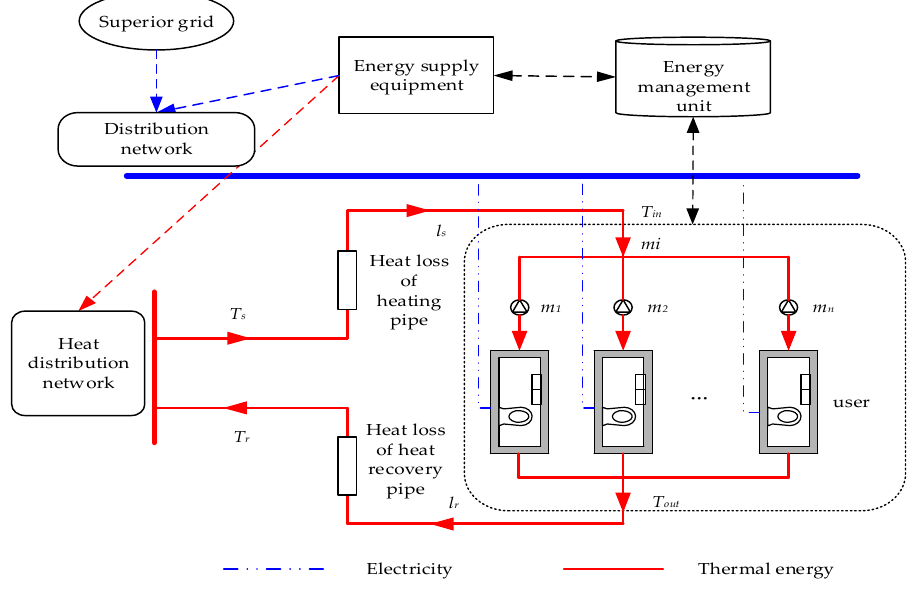
Figure 3. DR structure of users.